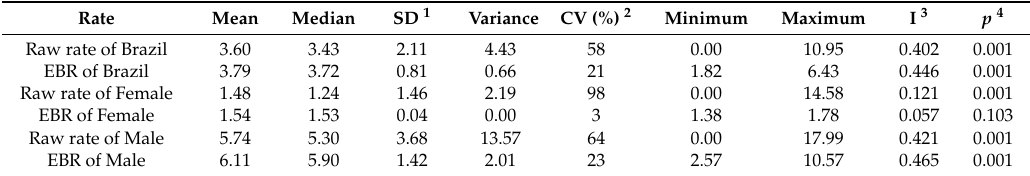
Table 1. Descriptive statistics and Global Moran Index of OOCM rates in Brazil,